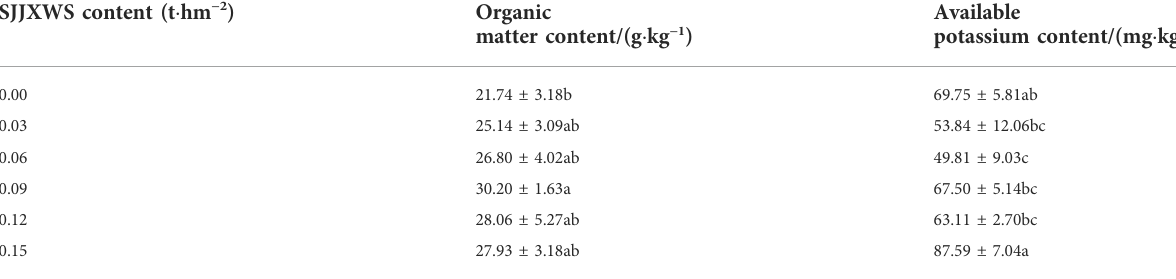
TABLE 5 Experiment 2: Nutrient composition of the functional